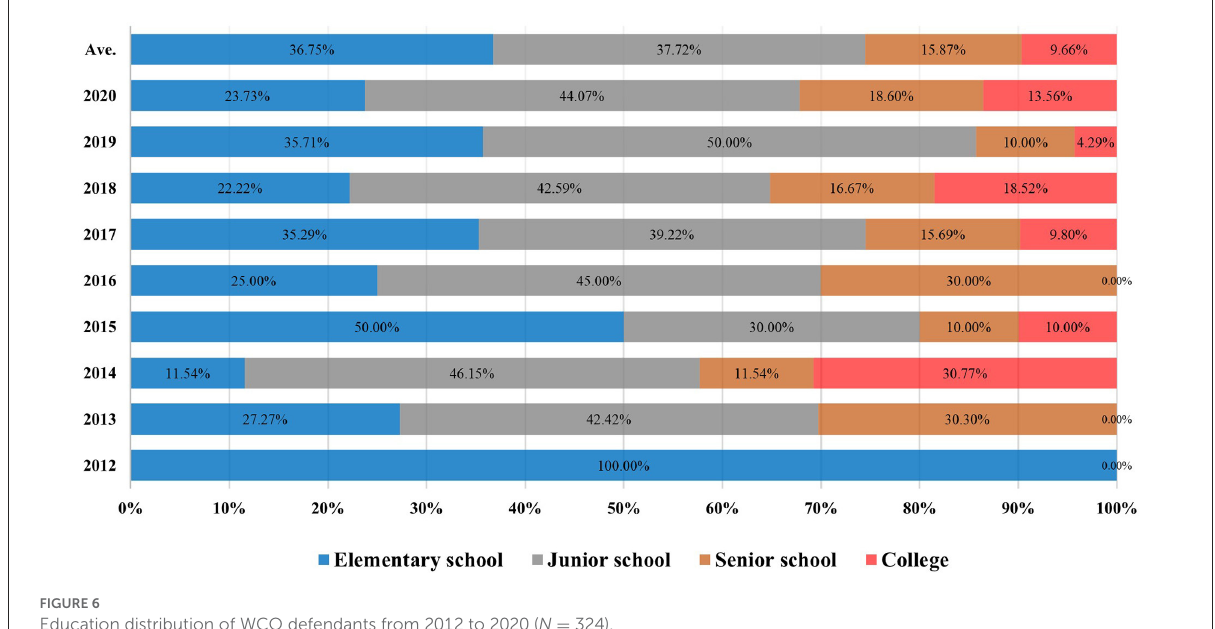
FIGURE6 Education distribution of WCO defendants from 2012 to 2020 ( N = 324).